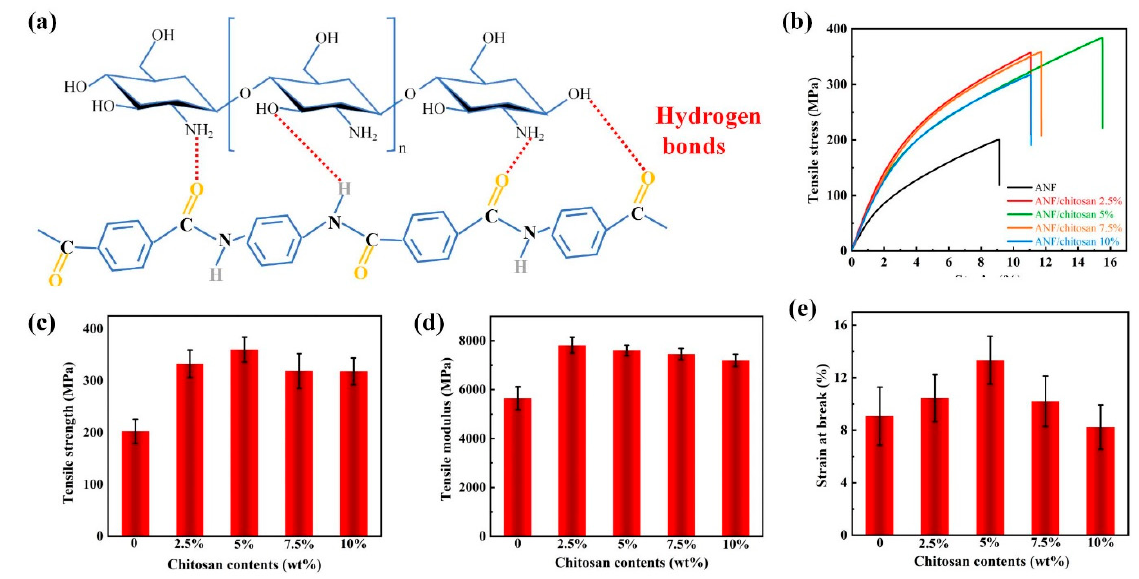
Figure 2. Mechanical properties of ANF/chitosan composite films. ( a ) Schematic representation of the formation of intermolecular hydrogen bonding between chitosan and ANF. ( b ) Typical stress–strain curves of ANF/chitosan composite films at different chitosan contents. ( c – e ) Tensile strength, tensile modulus, and break elongation of ANF/chitosan composite at different chitosan contents.